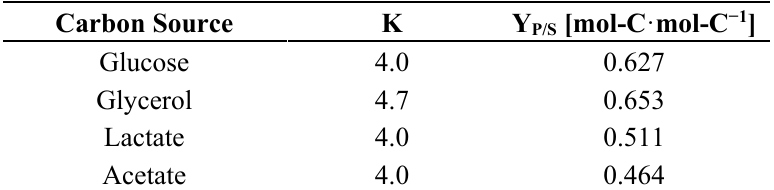
Table 1. Theoretical metabolic capacity of C. glutamicum for putrescine production with respect to different carbon sources. The carbon uptake was constrained to 24 mmol-C gDCW −1 ·h −1 . The degree of reduction (Κ) and the yield of putrescine on the indicated carbon source Y P/S are